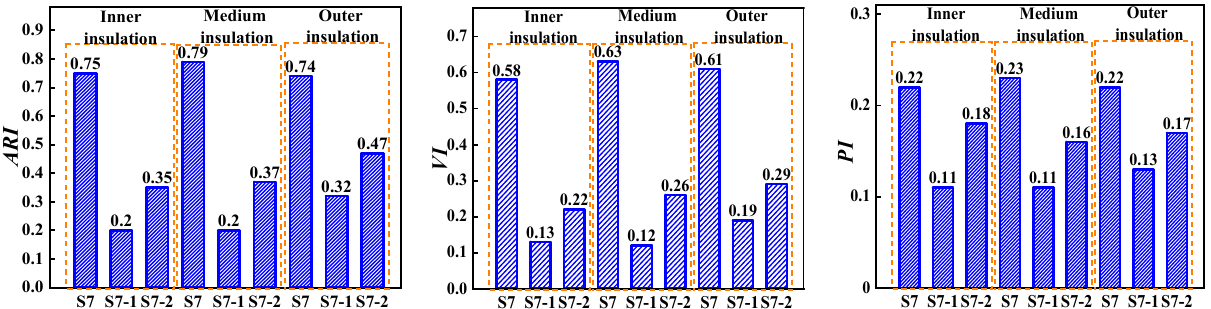
Figure 6. The change in ARI , VI , and PI of each insulating layer before and after the combined electrothermal aging test.